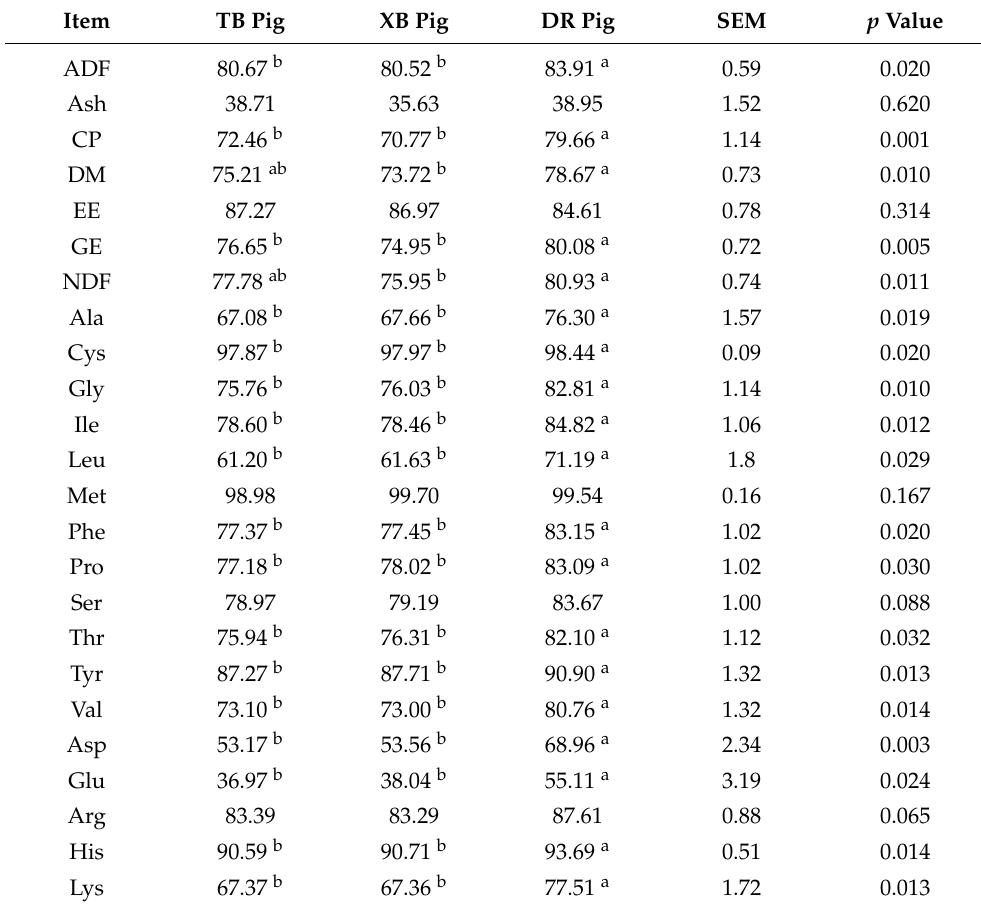
Table 13. Apparent total tract digestibility of three pig breeds at 125 days of age